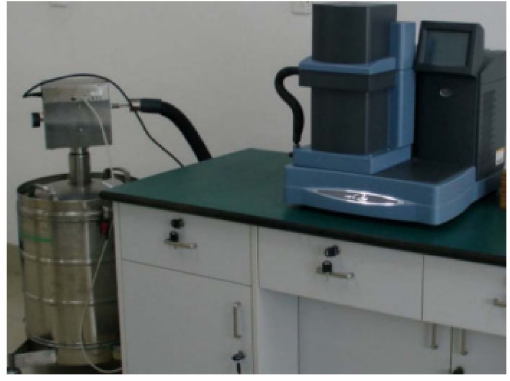
Figure 6. Dynamic Mechanical Analyzer.